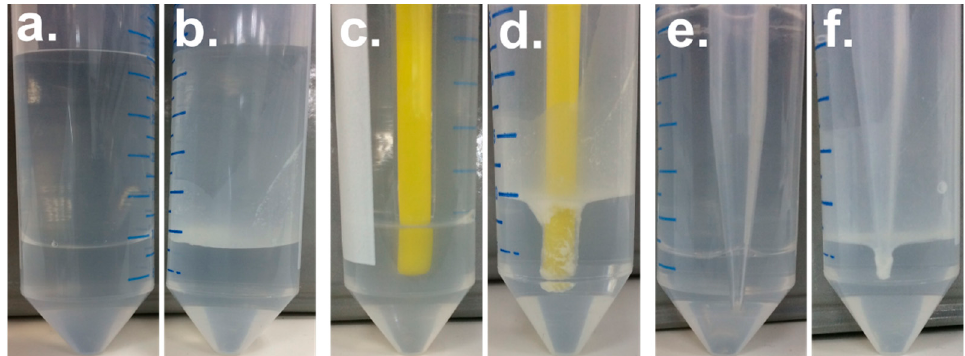
Figure 8. PMSQ-COOH amphiphilic Janus and bare PMSQ particles in a water–chloroform biphasic system. ( a , c , e ) Bare PMSQ particles. ( b ) PMSQ-COOH amphiphilic Janus particles at the interface. ( d ) PMSQ-COOH amphiphilic Janus particles adsorbed to the polar glass tip caused by the interaction of their hydrophilic hemispheres with the glass surface. ( f ) PMSQ-COOH amphiphilic Janus particles adsorbed to the polypropylene tip as a result of the interaction of their hydrophobic hemispheres with the polypropylene tip.